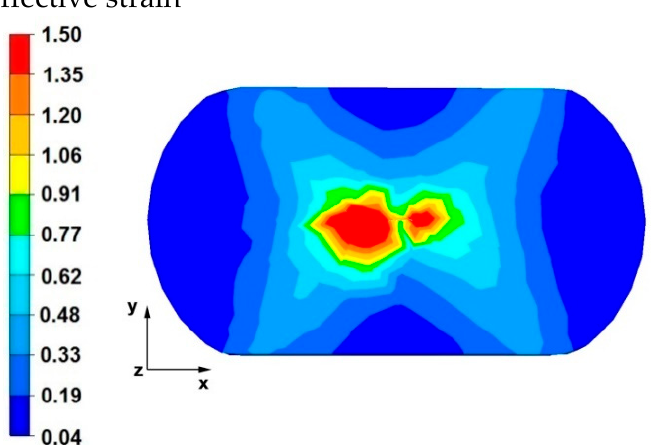
Figure 3. Distribution of the effective strain values on the surface of the cross-section of the sample with modeled discontinuity after deformation with 35% reduction.